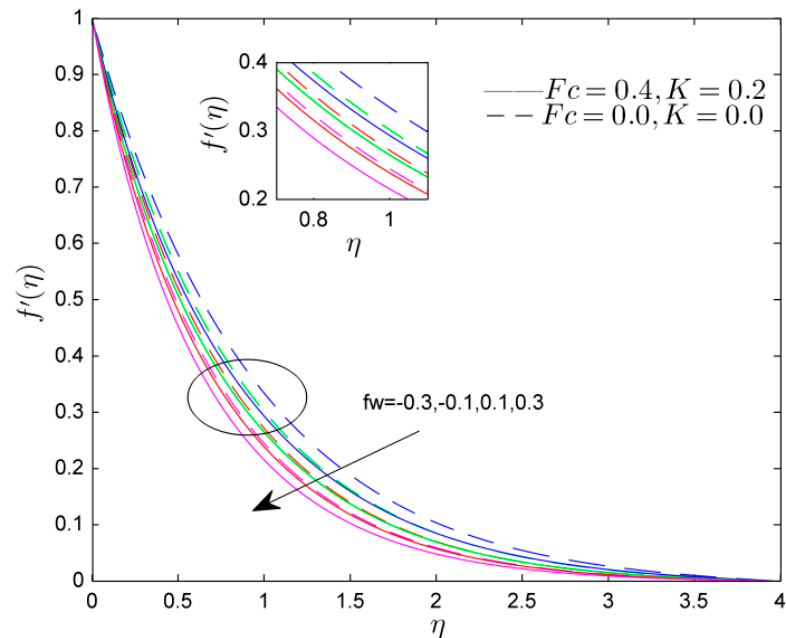
Figure 3. Effect of Suction/Injection parameter ( fw ) on f (cid:48) ( η ) .